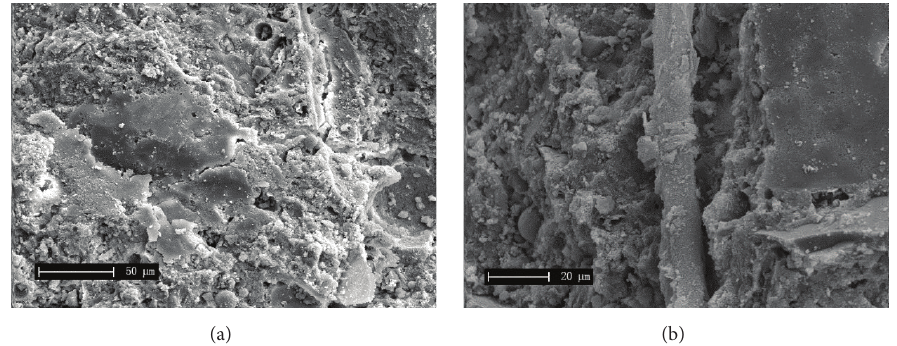
Figure 9: SEM images of microstructure of CFRC exposed at 300 ∘ C for 5.5 h at (a) 1000x and (b) 2000x magnification.